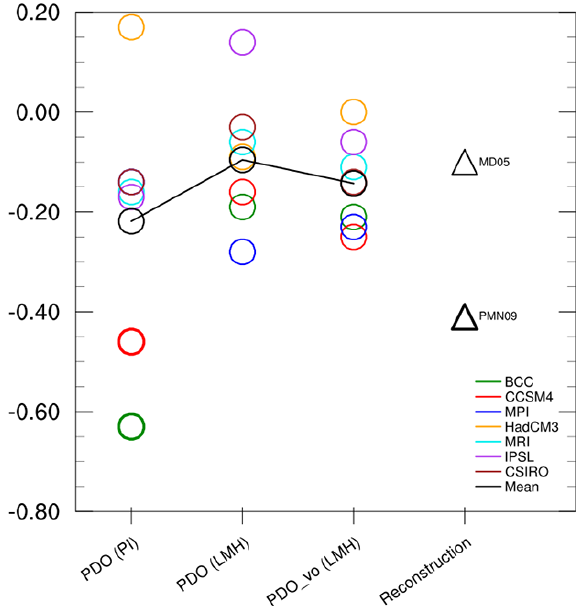
Figure 6. Correlations of annual-mean East Asian regional aver- age surface temperature against PDO index for each GCM (circles) for PI and LMH experiments compared with reconstructions (trian- gles). The mean correlations for the seven GCMs are marked with black circles connected by a solid line; “vo” indicates that the vol- canic influence on East Asian temperature has been removed by linear regression in the LMH experiments. The thick circles and tri- angles show values significant at 95% level using a two-tailed Stu- dent’s t test. The reconstruction correlations are between the WN18 East Asian temperature and the two PDO reconstructions (Table